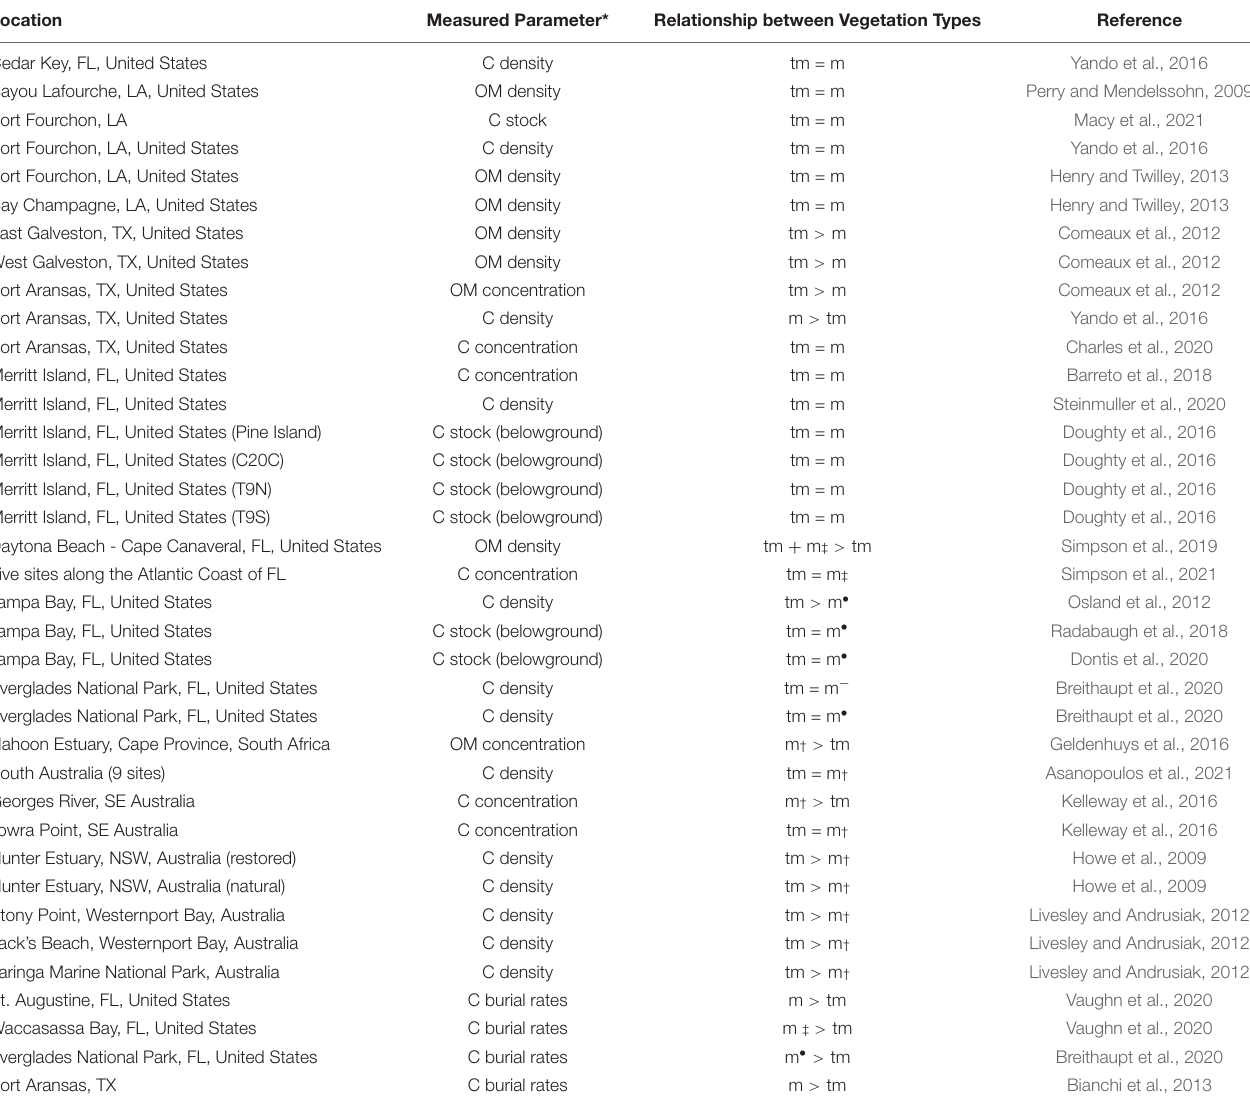
TABLE 3 | Relationship of measured soil carbon or organic matter characteristics [density (g cm − 3 ), belowground C stocks (Mg ha − 1 ), concentration (g kg − 1 ), and burial rates (g C m − 2 y − 1 )] between vegetation types (mangrove = m; tidal marsh = tm) at locations along encroachment fronts in the northern Gulf of Mexico, southeastern Australia, and South Africa (ordered by